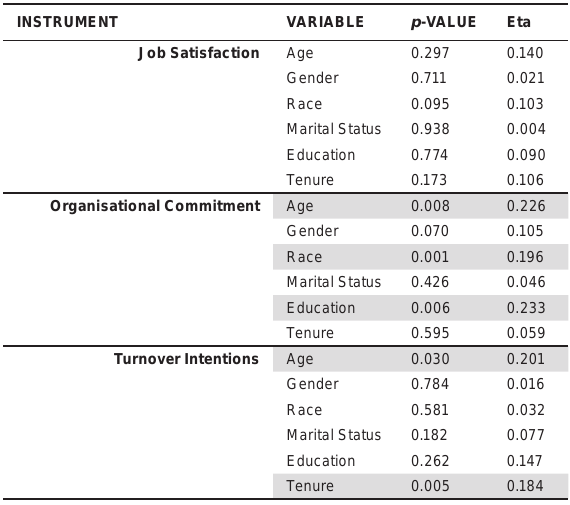
tABLe 3 Summary of testing between background variables and instruments